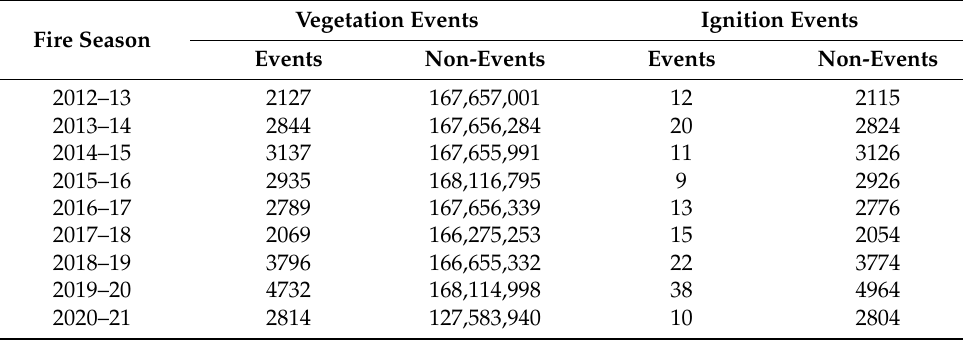
Table 2. Counts of vegetation and ignition events during the modelling